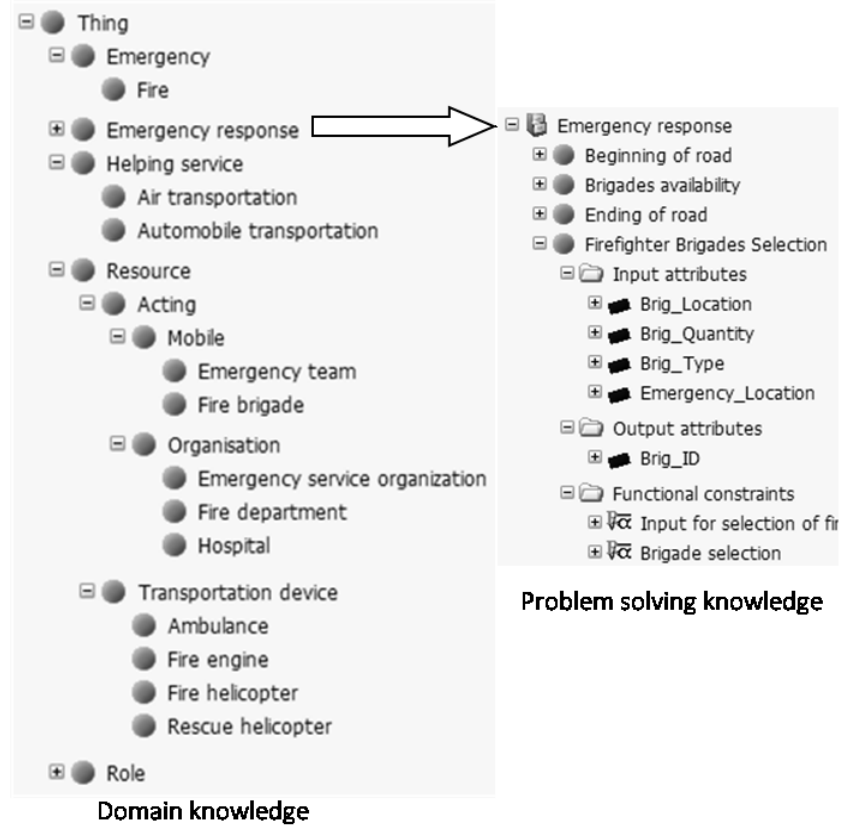
Figure 1. Abstract context for fire situation: concept view (a fragment)